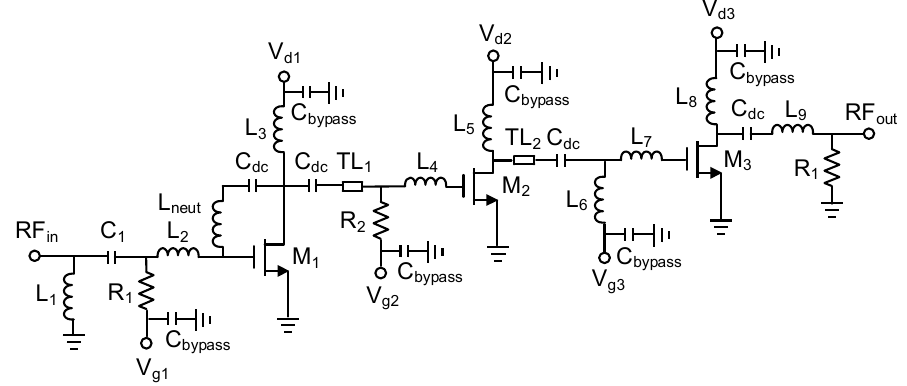
Figure 1. Schematic of the full Ka-band amplifier with flat gain.